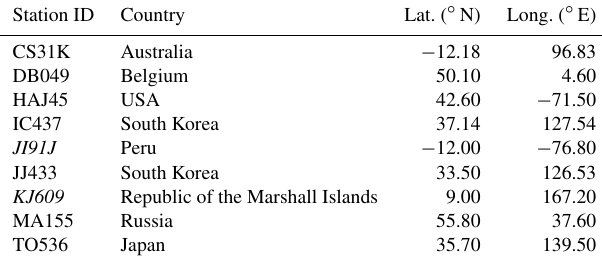
Table 2. Ionosonde stations used for validation purposes. Ionosonde stations with italic font are used for assimilation and